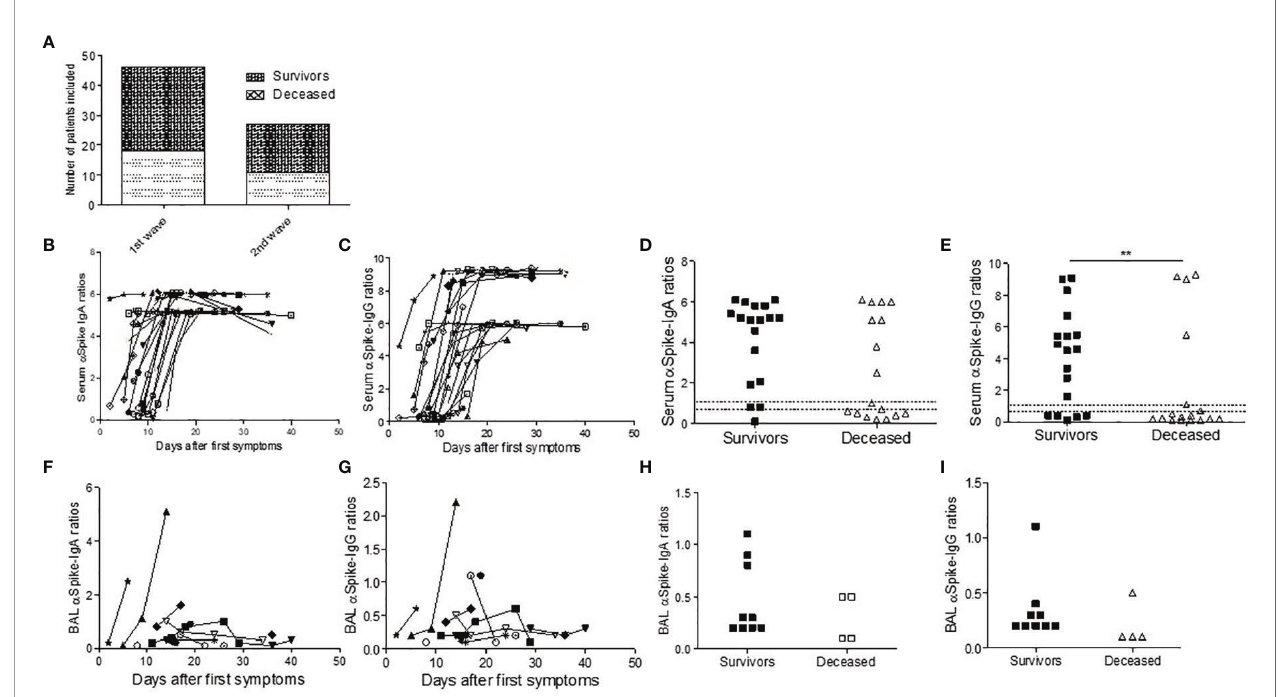
FIGURE 1 | SARS-CoV-2 antibody response in ICU COVID-19 patients. Number of patients tested during the fi rst and second wave (A) . (B – I) Antibodies against the S1 domain of the spike protein were measured in ELISA assay in fi rst-wave survivors (closed symbols) or deceased (open symbols) patients at different time points from fi rst COVID symptoms. (B, C) Serum IgA (B) and IgG responses (C) are depicted during ICU stay. (D, E) First time point IgA (D) and Ig IgG (E) titers in survivors and deceased patients. In BAL, the IgA (F, H) and IgG (G, I) antibody response was weak in deceased patients (open symbols) when compared to survivors (closed symbols). Chi-square test was used for serology comparison, while Mann – Whitney test was used for comparing BAL antibody